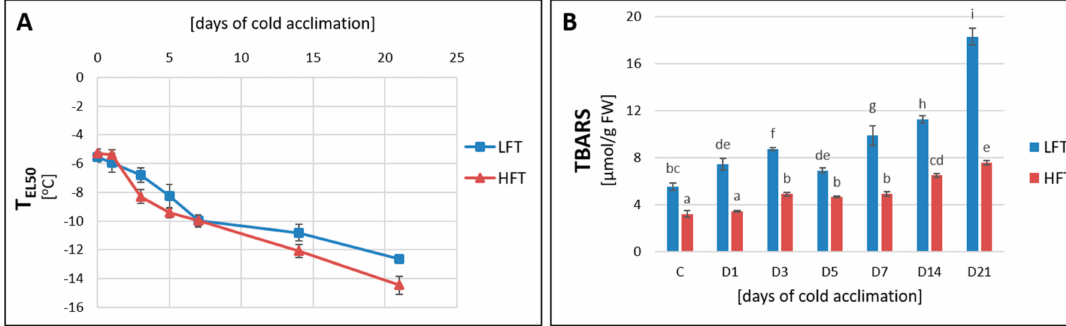
Figure 1. Changes in T EL50 (temperature causing a 50% electrolyte leakage-EL) ( A ) and thiobarbituric acid reactive substances (TBARS) content ( B ), at seven time-points: before cold acclimation (CA) C and on the 1st, 3rd, 5th, 7th, 14th, and 21st day of CA in Lolium multiflorum / Festuca arundinacea introgression forms. Error bars represent confidence intervals for p = 0.05 ( A ) and standard errors of five replicates ( B ). Homogeneity groups are denoted by the same letters, according to Fisher’s LSD test ( p = 0.05). HFT–high freezing tolerant introgression form, LFT–low freezing tolerant introgression form; FW–fresh weight.